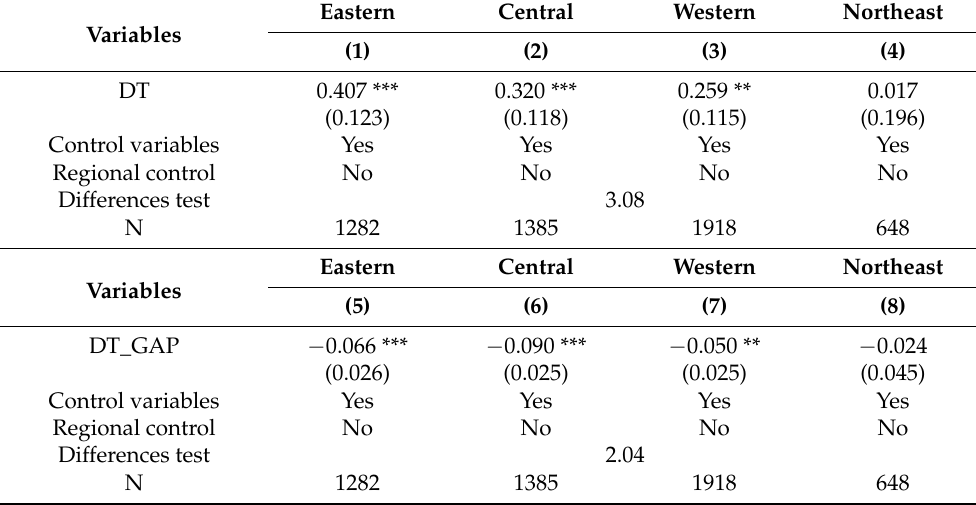
Table 8. Regional heterogeneity: test results of the impact of DT & DT_GAP on LRB. Variables